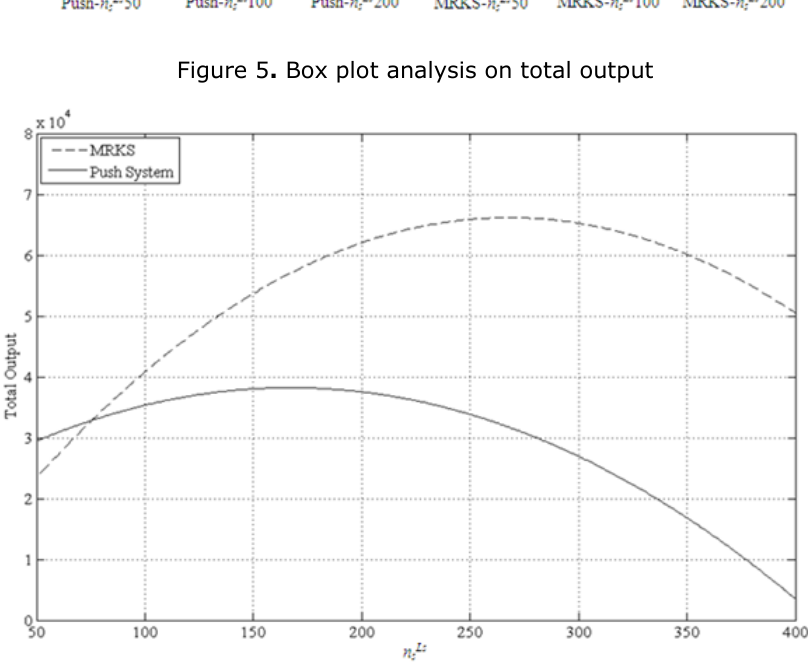
Figure 6. Effect of n sLs on total